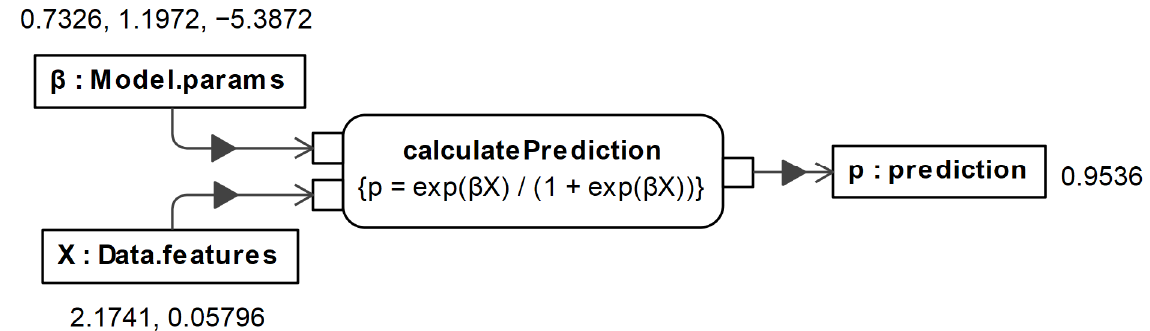
Figure 6. Running example of the calculatePrediction function featuring the logistic regression inference. The shown data instance corresponds to the ground-truth class label, in this case, the target class instance (Data.class = 1), which is not used in the calculations.